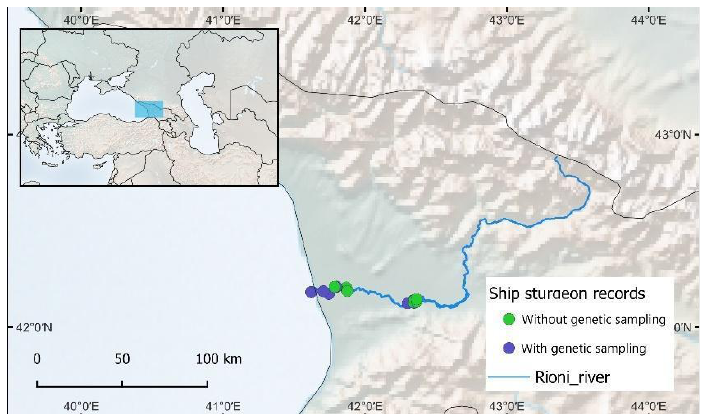
Figure 1. Ship sturgeon sampling sites in the Rioni River in Georgia.